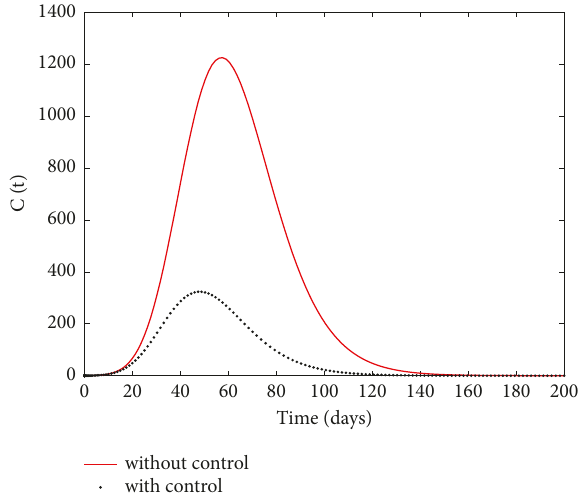
Figure 20: Behaviour of COVID-19 patients with diabetes with and without control.